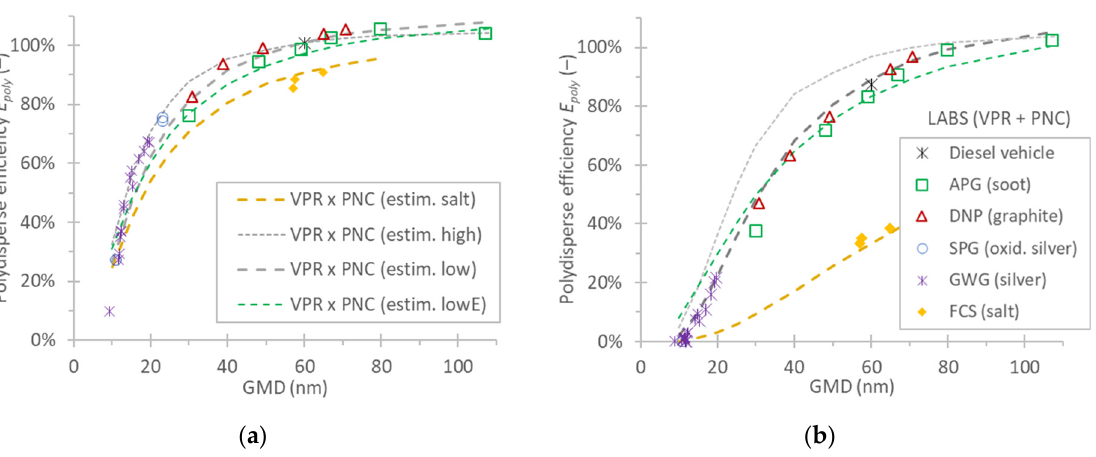
Figure 8. Comparison of estimated (VPR × PNC) and measured (LABS = VPR + PNC) system effi-ciency with polydisperse aerosol: ( a ) 10 nm system; ( b ) 23 nm system. Assumed geometric standard deviation (GSD) for salt 1.85, GSD for low and high scenarios 1.5–1.6, GSD for LowE scenario 2.1. The PCRF of the LABS was 100. Note that the legend is split in the two panels.